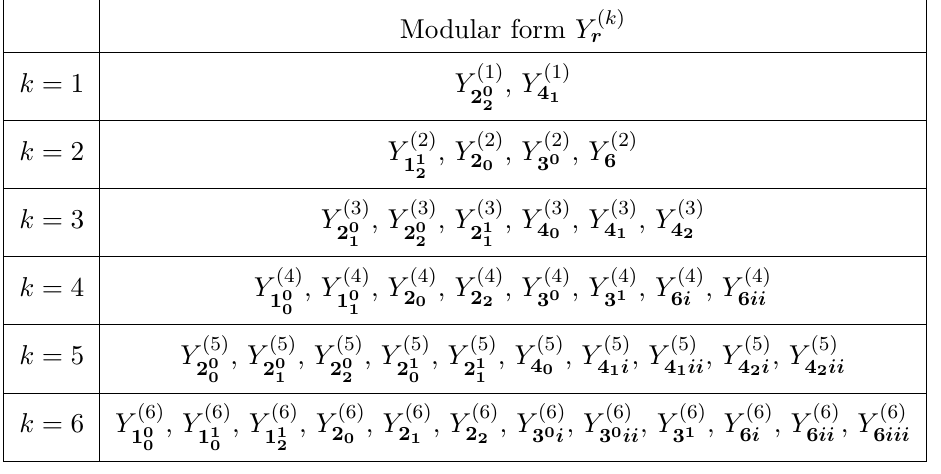
Table 7 . Integral weight modular multiplets of level 6 up to weight 6, the subscript r denotes the transformation property under homogeneous finite group Γ 0 six-dimensional modular multiplets of Γ 6 of weight 4. The same convention is adopted for other modular forms. Notice that the modular miltiplets Y ( k ) the modular multiplets Y ( k ) r = 0 , 1 and k = 0 , 1 , 2